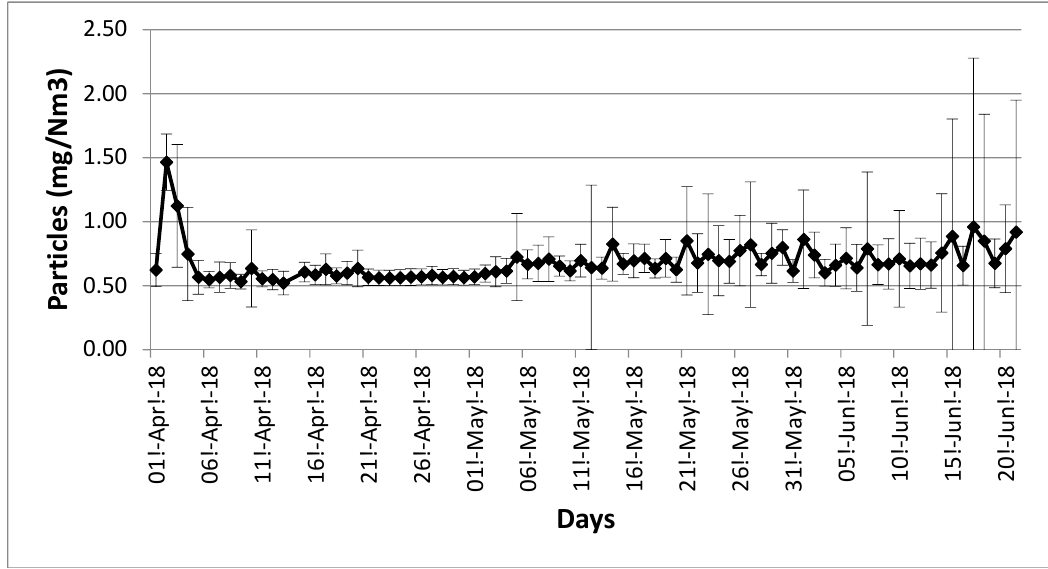
Figure 3. Particle concentration emitted from the stack during the period 1 April 2018 to 21 June 2018.